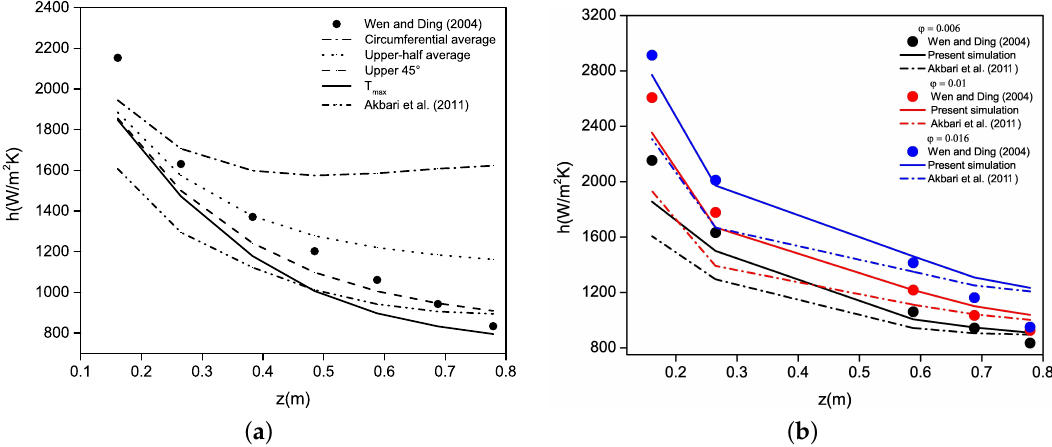
Figure 3. Axial variations of the local heat transfer coefficient h ( z ) predicted by the mixture model for Al 2 O 3 water-based nanofluids: ( a ) different methods for the evaluation of the wall temperature T w for ϕ = 0.006; ( b ) three nanoparticle concentrations ( ϕ = 0.006, 0.01 and 0.016). Comparisons for Re = 1600 and d np = 42 nm with the experimental data of Wen and Ding [11] and the numerical simulations of Akbari et al.